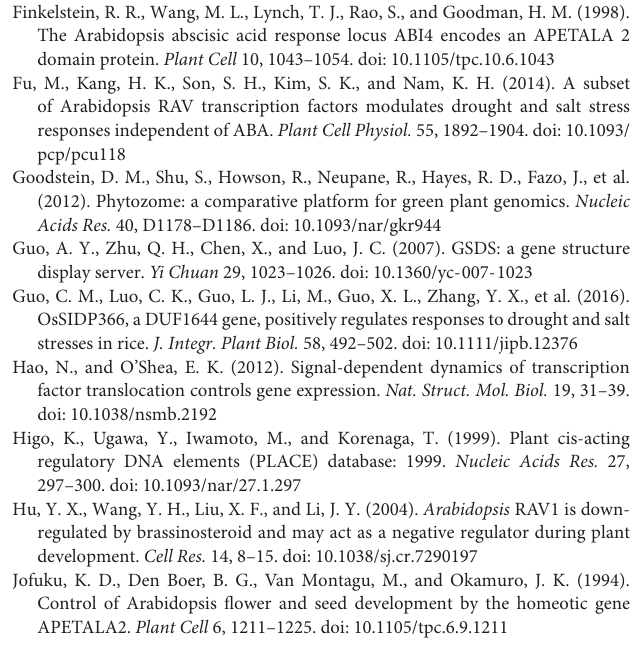
FIGURE S1 | Relative expressions of transgenic lines and wild line (WT). qRT-PCR data were normalized using Arabidopsis Actin gene and shown relative to WT. X-axes showed different lines and scales of relative expression level (error bars indicate SD). FIGURE S2 | Distribution of soybean RAV genes in the genomes of soybean and Arabidopsis . The blue bars represent the chromosomes, and the chromosome numbers are shown on top of the bars. Note that the length of the bar has no relationship with the size of the chromosomes. The numbers on the left side of the chromosomes show the distances between the neighboring genes; the unit of distance here is the megabase (Mb). (A) Distribution of soybean RAV genes in the soybean genome. Soybean RAV genes are distributed on eight chromosomes. (B) Distribution of Arabidopsis RAV genes in the Arabidopsis genome. The AtRAV genes are distributed on five